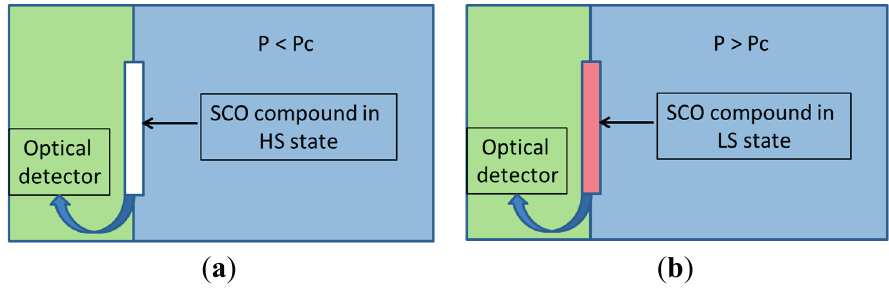
Figure 1. SCO material used as pressure sensor: ( a ) the SCO material reflects the light to the detector, indicating that the pressure is below the critical point; ( b ) the SCO material does not reflect the light to the detector, indicating that the pressure is above the critical